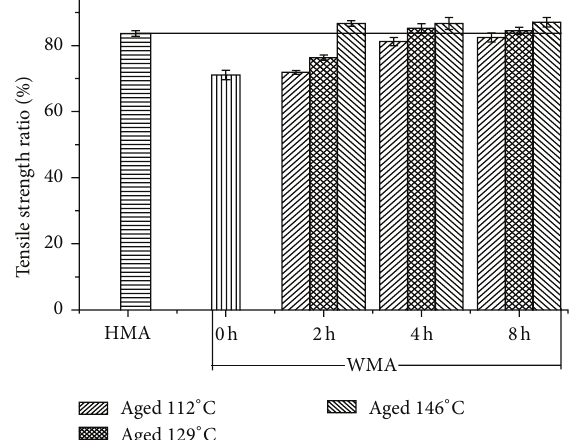
Figure 3: Change in the freeze-thaw splitting strength ratios as a function of aging temperature and